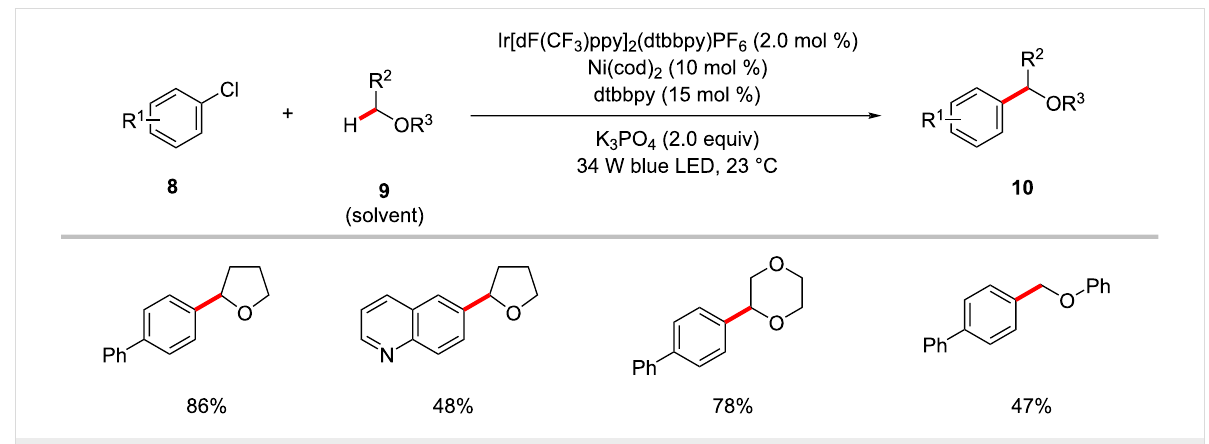
Scheme 5: Nickel-catalyzed α -oxy C(sp 3 ) − H arylation of cyclic and acyclic ethers.